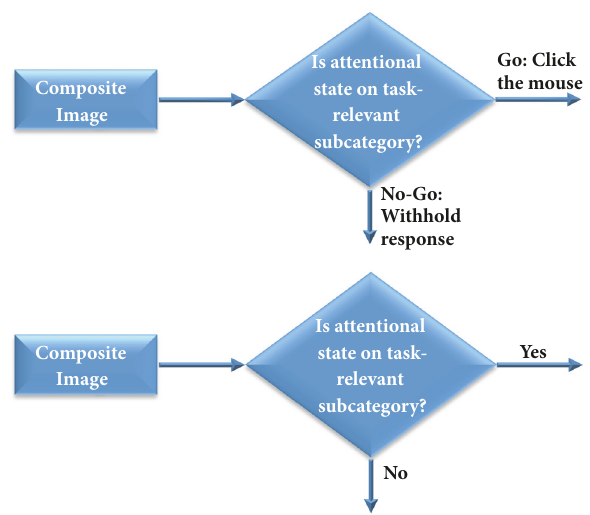
Figure 2: The method for computing behavioral response for a participant (top) and calculating the brainwave classification result for a participant